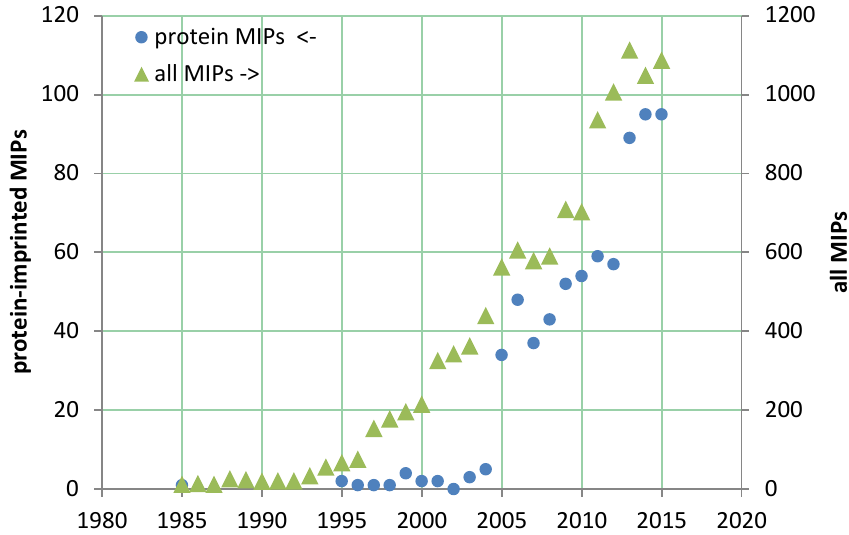
Figure 2. Number of publications on protein-imprinted (circles) and all molecularly imprinted (triangles, right axis) polymers, until the end of 2015 (generated by means of MIPdatabase [16]).